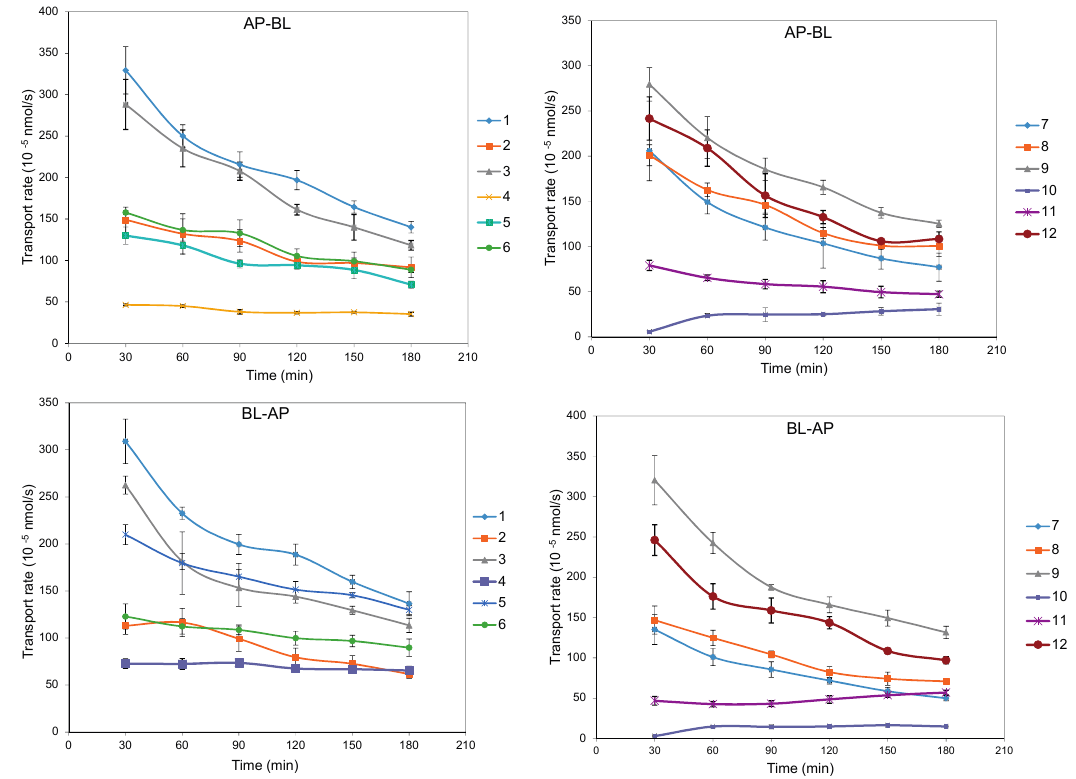
Figure 3. The bidirectional transport rate of twelve coumarins in MDCK-pHaMDR cell monolayer as a function of time at 50 μ M. Data are the mean ± S.D. ( n =